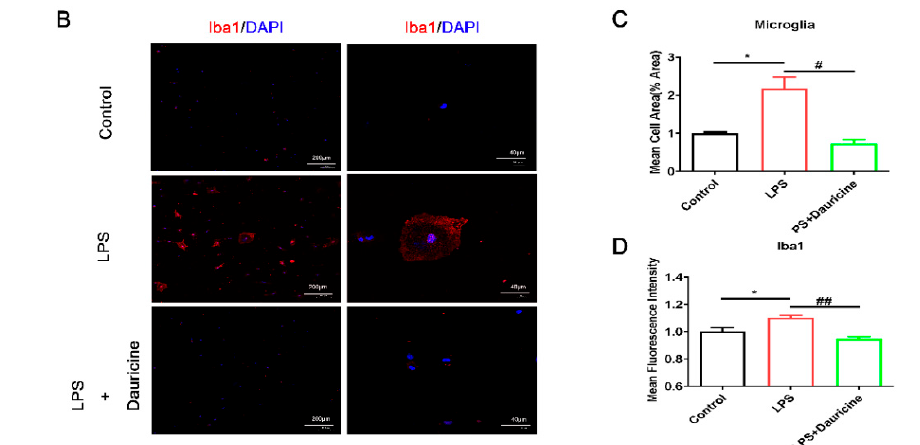
Figure 3. Dauricine inhibited the activation of microglia in vitro and in vivo. ( A ) The representative figures of brain sections in MCAO at day 7 strained with immunofluorescence of Iba1 and DAPI are shown in the full brain and in a three-dimensional view. ( B ) The representative figures of primary microglia cells induced by LPS or dauricine for 3 h in vitro. The mean cell area (%) of microglia cells was counted ( C ) and the mean fluorescence intensity of Ibal was counted ( D ). n = 3, Control group vs. LPS group, * p < 0.05; LPS group vs. (LPS + Dauricine) group, # p < 0.05, ## p < 0.01, unpaired Student’s t -test.